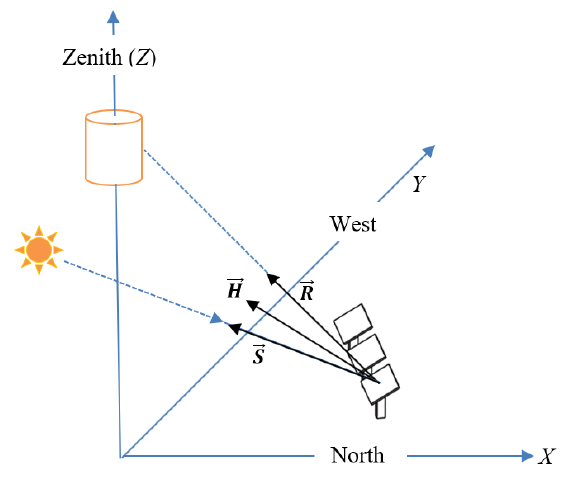
Figure 2. Unit vectors 𝑆 , 𝑅⃗ and 𝐻⃗⃗ in a Cartesian coordinate system.